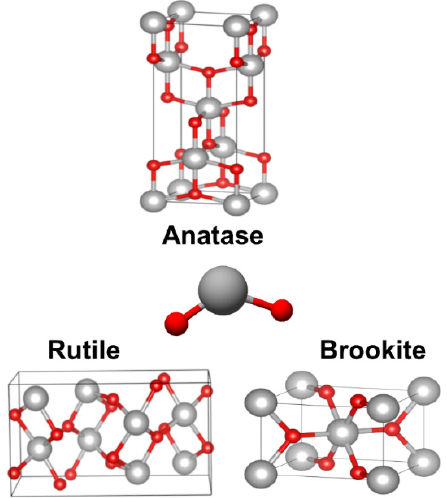
Figure 6. Anatase (tetragonal), rutile (tetragonal), and brookite (orthorhombic), structures of TiO 2 [100–102]. This figure was created using VESTA Version 3, with permission from Journal of Applied Crystallography, VESTA 3 for three-dimensional visualization of crystal, volumetric and morphology data, K. Momma and F. Izumi, Free Software, 2011.